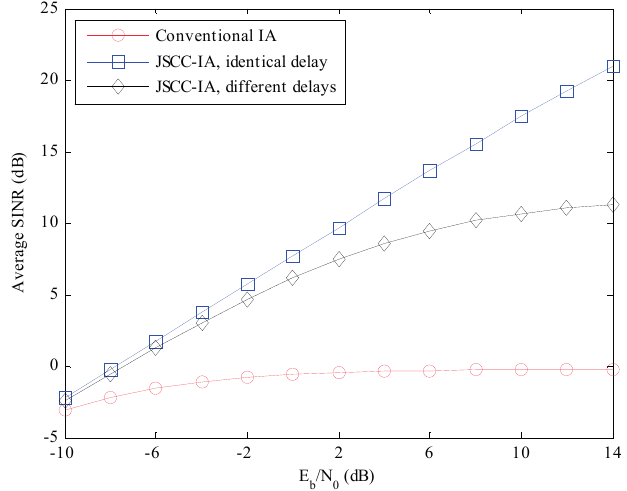
Figure 9. The average received SINR of the conventional IA scheme and the JSCC-IA schemes with identical/different propagation delays in the (4 × 4, 1) 20 symmetric networks.